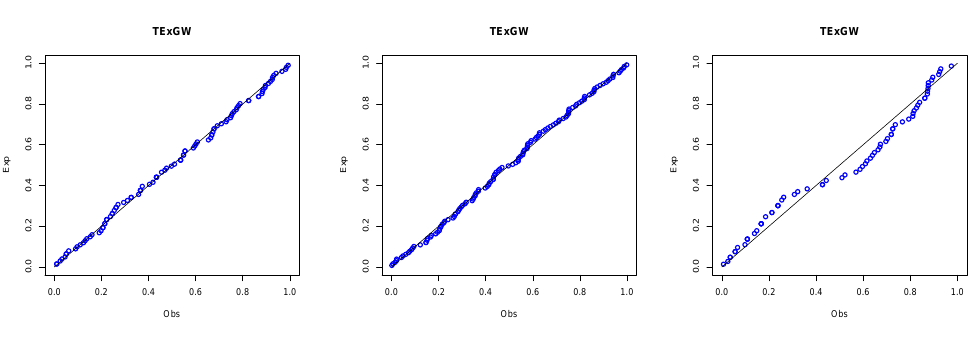
Fig. 8. QQ plots for the TExGW model for the three data sets respectively from left to